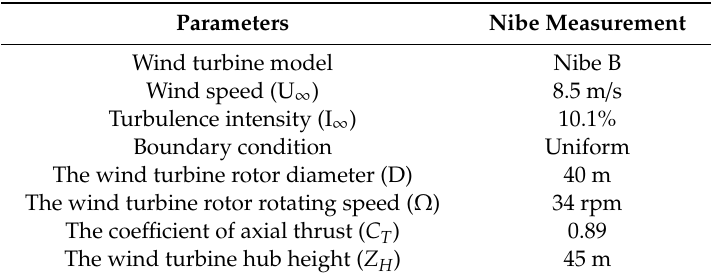
Figure 7. Measurement schematics of meteorological masts (MMs) at Nibe. Table 2. Parameters of the wind turbines.